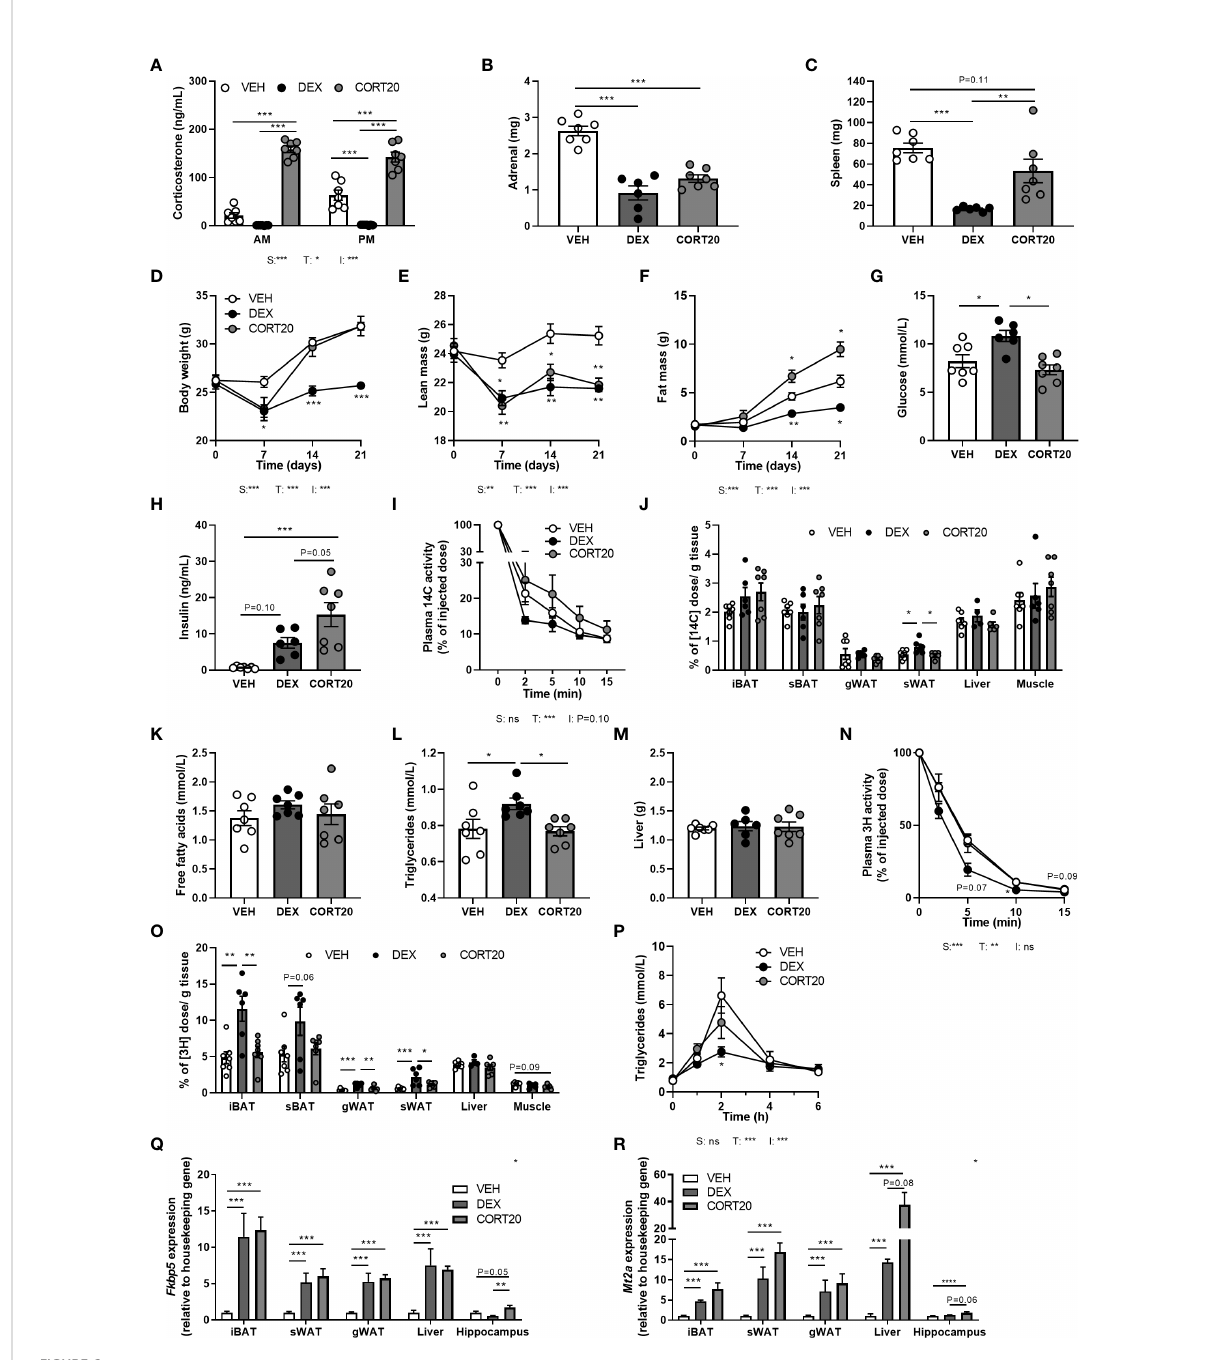
FIGURE 6 High-dose corticosterone causes different metabolic effects than dexamethasone. Mice received a high-fat diet mixed with dexamethasone (DEX) or vehicle (VEH) and were subcutaneously implanted with high-dose corticosterone (CORT20) or vehicle pellets for 3.5 weeks. The VEH and DEX